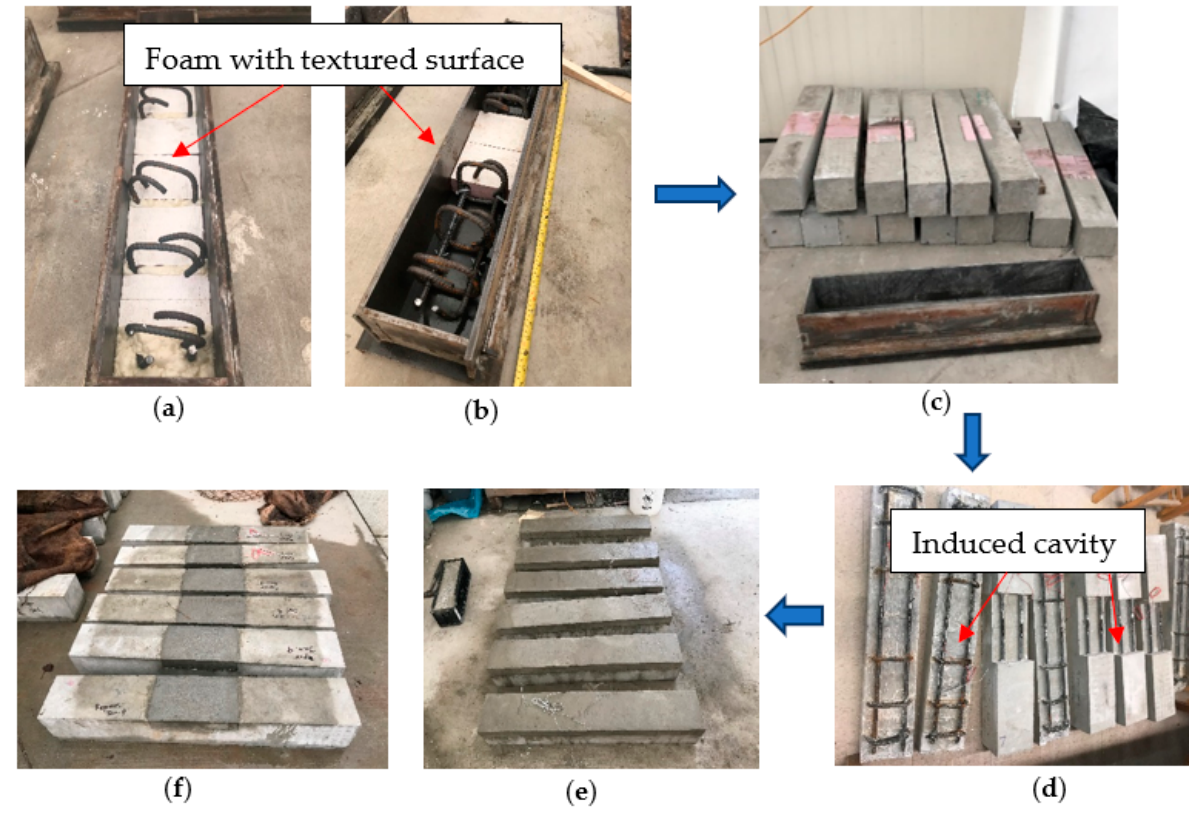
Figure 2. Sample preparation procedures ( a ) Inserting foam for full-length repaired beams ( b ) In- serting foam for 1/3-span repaired beams ( c ) demolded samples ( d ) Samples with foams removed ( e ) Full-length repaired beams ( f ) 1/3-span repaired beams.